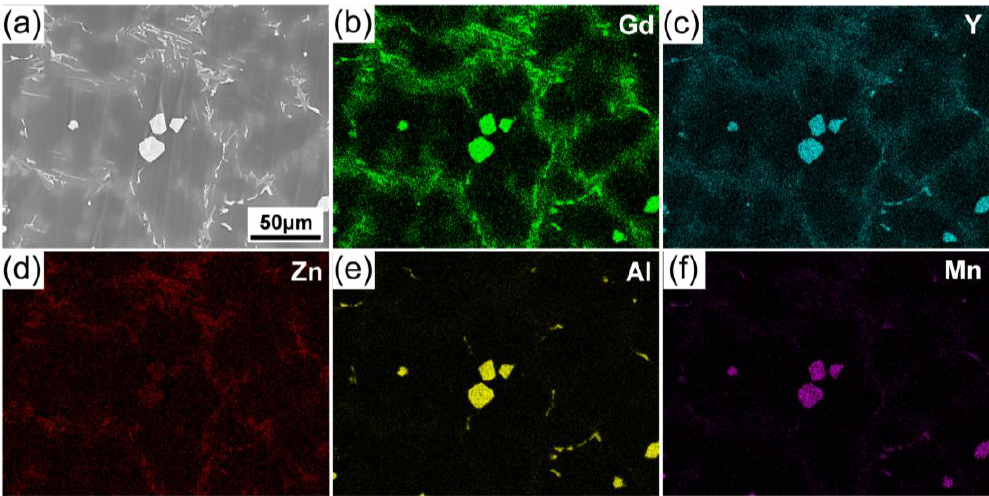
Figure 3. SEM image and EDS elemental maps of eutectic phases in as-cast 0.5Zn-1.0Al alloy: ( a ) SEM image and ( b – f ) EDS elemental maps of Gd, Y, Zn, Al and Mn.